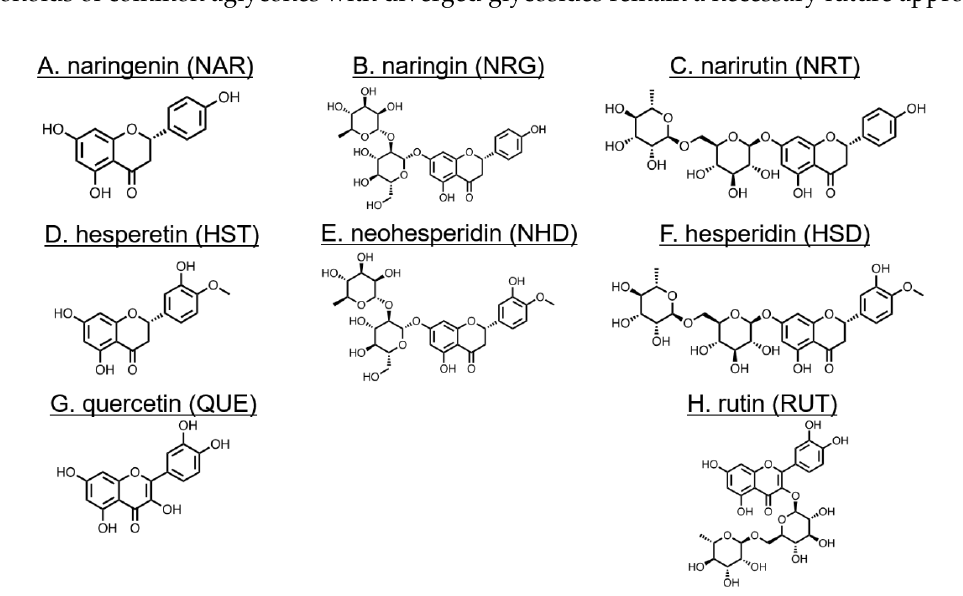
Figure 1. Chemical structures of flavonoids and their abbreviations. ( A ) naringenin (NAR), ( B ) naringin (NRG), ( C ) narirutin (NRT), ( D ) hesperetin (HST), ( E ) neohesperidin (NHD), ( F ) hesperidin (HSD), ( G ) quercetin (QUE), and ( H ) rutin (RUT).